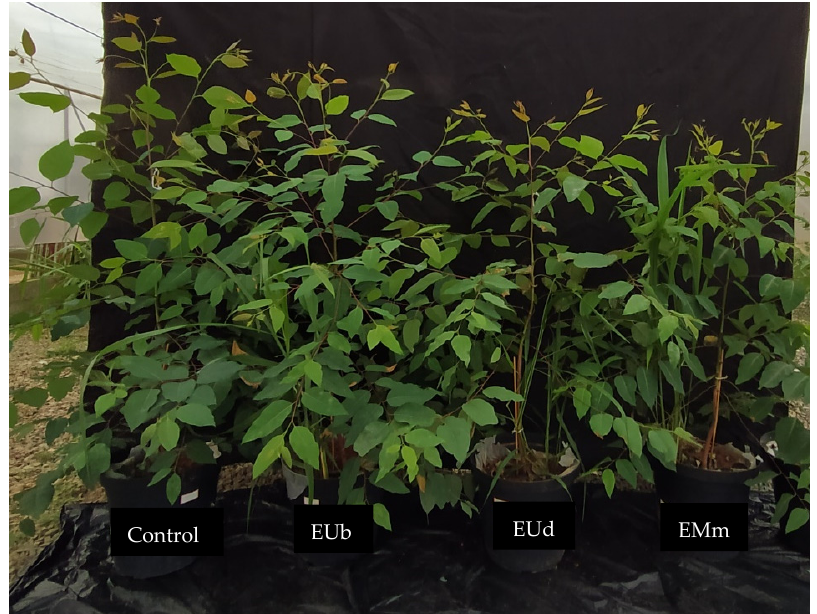
Figure 2. Height of eucalyptus clonal hybrid I144 ( Eucalyptus urophylla × Eucalyptus grandis ) in competition with grasses at 110 DAT. Control: eucalyptus without competition; EUb: competition with U. brizantha ; EUd: competition with U. decumbens ; EMm: competition with M. maximus .